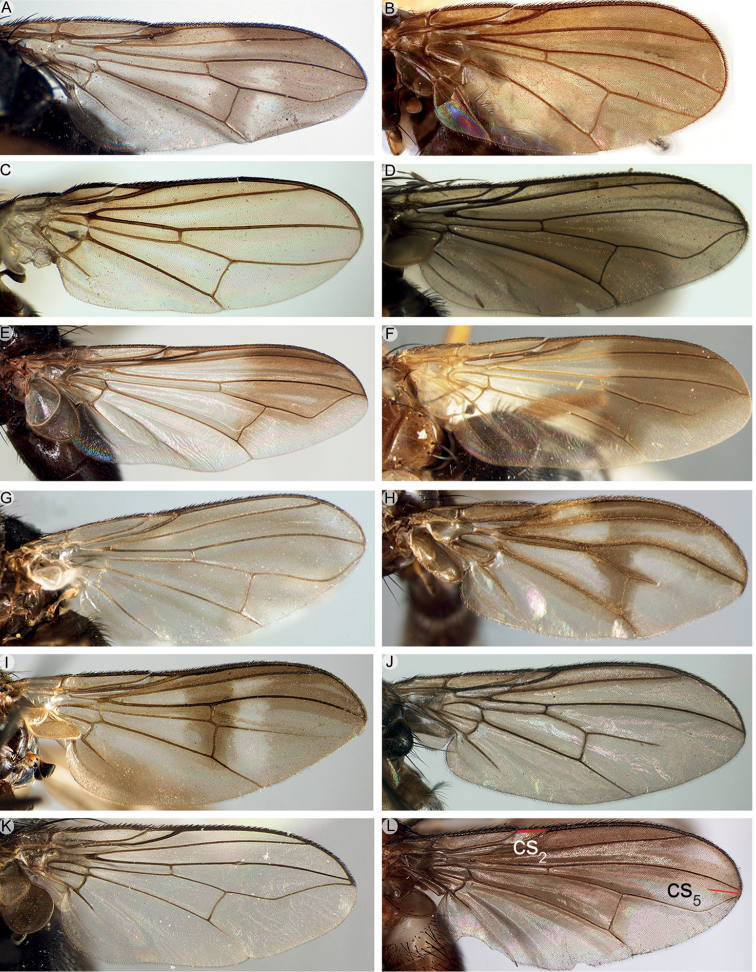
Rhinophoridae, wing. AApomorphyto
inbio ♂ (Costa Rica) [holotype] BAporeomyia sp. (Malaysia, Sabah) ♂ CAxinia
cf.
brevispica ♀ (Australia) DAzaisia sp. ♂ (Portugal, Madeira) E, FBaniassa
fascipennis (Israel) E ♂ [paratype] F ♀ [paratype] GBixinia
collessi ♂ (Australia) [paratype] HBezzimyia
bisecta ♂ (Costa Rica) IBezzimyia
busckii ♂ (Costa Rica) JMelanophora
basilewskyi ♀ (Kenya) KMetoplisa
carbonaria ♂ (Israel) LParazamimus
congolensis ♂ (Burundi).